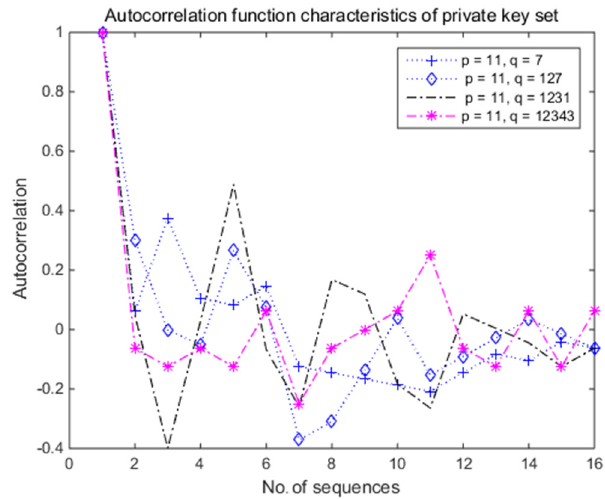
Figure 5. Autocorrelation function characteristics of 16-bit private key set with prime numbers ( p , q ) = ( 11, 7 ) , ( 11, 127 ) , ( 11, 1231 ) , and (11, 12,343).